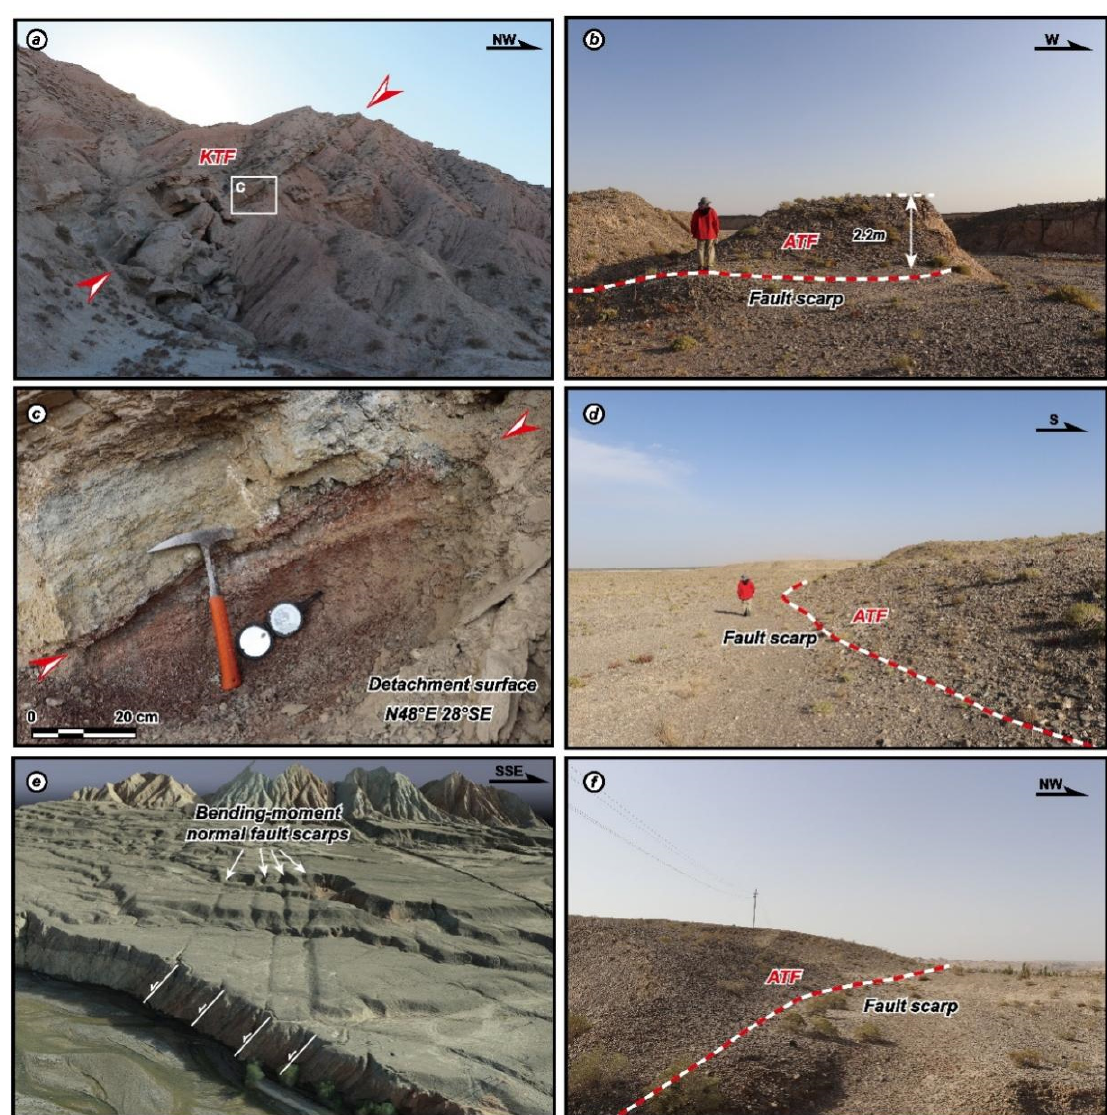
Figure 8. Typical field photographs showing the surface rupture zones observed along the ATF and KTF. ( a ) Photograph showing the development of active fault and collapse in Kalawengkuer, collapses are comprised of N 1 sandstone and siltstone. Location is shown as Site 2 in Figures 2b and 5b; ( b ) photograph showing a ~2.2-m-high fault scarp developed on T2, as a result of the 1902 Mw 7.7 Atushi earthquake. Location is shown as Site 3 in Figures 3b and 6b; ( c ) enlarged photograph showing the fault plane (as shown in Figure 8a) developed in the detachment layer, which consists of brownish red and grayish yellow siltstone, argillite, and gypsum; ( d ) photograph showing the surface deformation is characterized as fault scarp developed on T2, which was produced by the 1902 Mw 7.7 Atushi earthquake. Location is shown as Site 3 in Figures 3b and 6b. ( e ) UAV-based 3D visualization of bending-moment normal fault scarps in the south of Keketamu (as shown in Figure 2b). Four north-facing scarps, which developed at the core of KTA, are sub-parallel, closely-spaced arrangement; ( f ) photograph showing the surface rupture characterized as fault scarp, which is likely related to the 1902 Mw 7.7 Atushi earthquake. Location is shown as Site 4 in Figures 3b and 7b. Table 1. Throws measured along the ATF and KTF.